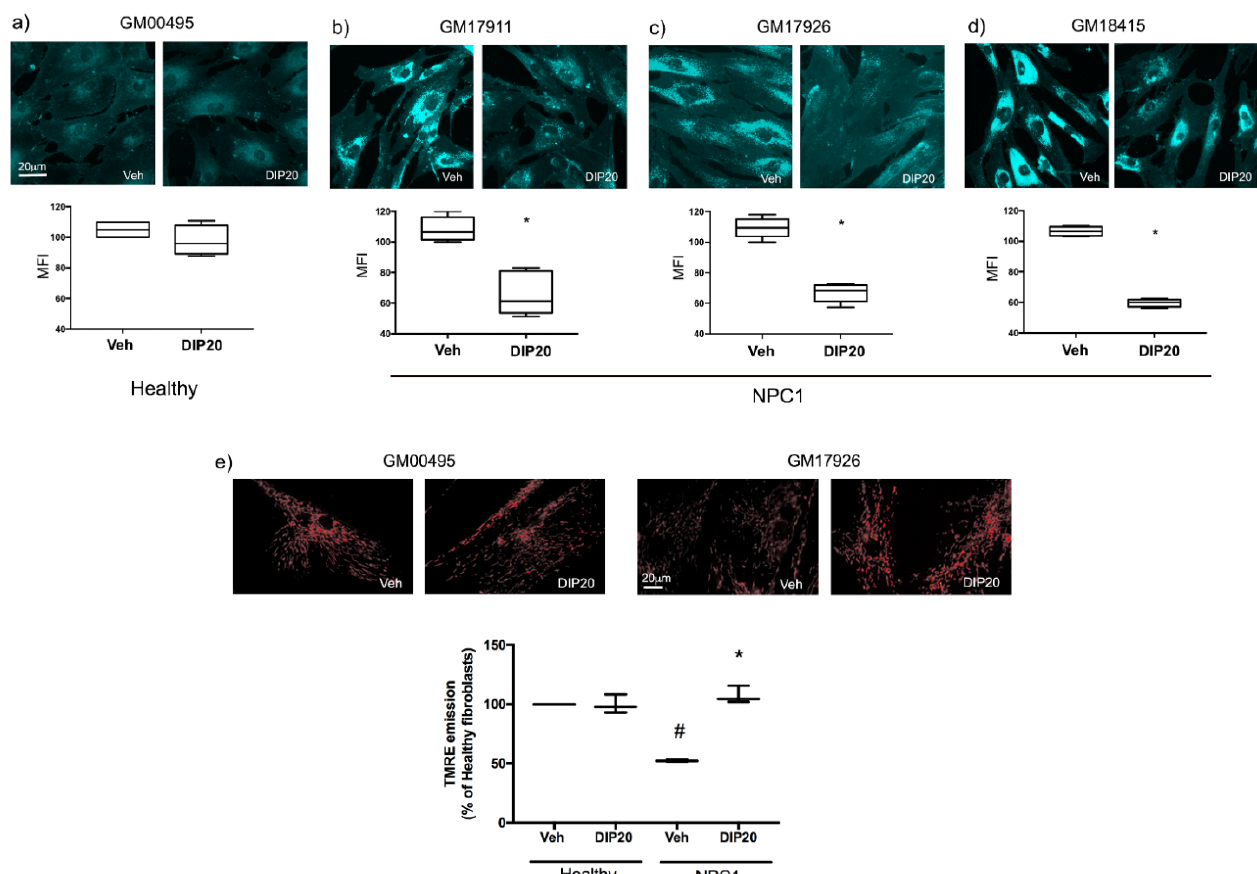
Figure 2. Effect of treatment with dipyridamole (DIP20: 20 µ M over 48 h) on intracellular cholesterol distribution and mitochondrial membrane potential (mMP) in healthy and NPC1 fibroblasts. Filipin III was used to visualize unesterified cholesterol distribution in cells; TMRE fluorescence intensity was used to measure mMP. ( a – d ) Representative images of Filipin III-stained GM00495 healthy and GM17911, GM17926, and GM18415 NPC1 fibroblasts, respectively; the graphs below show the quantification of mean fluorescence intensity (MFI) of Filipin III staining, expressed as percentage of veh-treated cells. ( a ) DIP20 did not affect the uniform distribution of cholesterol in GM00495 healthy fibroblasts ( n = 4 independent experiments). ( b – d ) DIP20 significantly reduced cholesterol accumula- tion in GM17911 ( n = 6 independent experiments), GM17926 ( n = 10 independent experiments) and GM18415 ( n = 4 independent experiments) NPC1 fibroblasts, respectively. ( e ) Representative images of TMRE fluorescence analysis in GM00495 healthy and GM17926 NPC1 fibroblasts; the graph below shows the quantification of TMRE fluorescence intensity expressed as a percentage of veh-treated GM00495 cells. mMP is decreased in veh-treated GM17926 NPC1 fibroblasts but DIP20 restored its levels to GM00495 healthy cells ( n = 3 independent experiments). * p < 0.05 vs. veh-treated NPC1 cells; # p < 0.05 vs. veh-treated healthy cells after two-tailed Student’s t -test in ( a ) and one-way ANOVA in ( b ). Data are expressed as box-plots (whiskers from min to max value). Scale bars = 20 µ